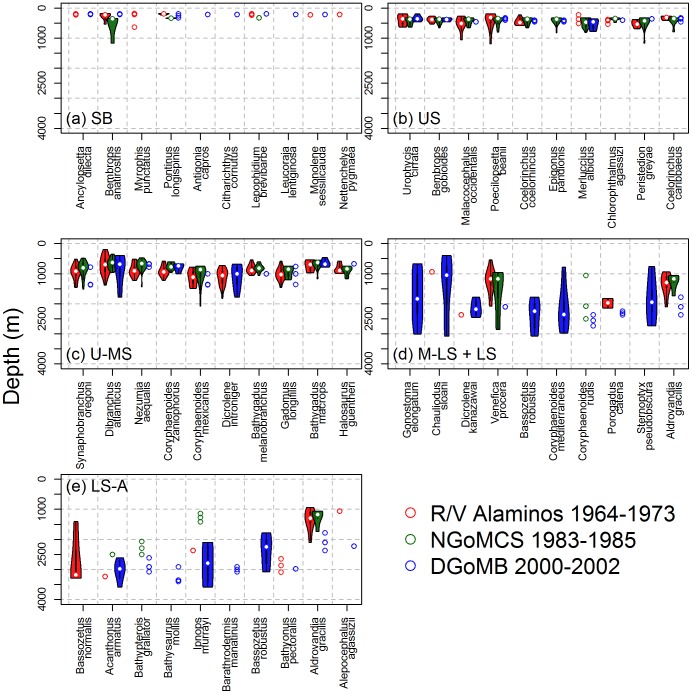
Violin plots of sampling depths for the top-10 most common species (with highest occurrence) from (a) Shelf Break, (b) Upper Slope, (c) Upper-to-Mid Slope, (d) Mid-to-Lower and Lower Slope, and (d) Lower-Slope-to-Abyssal Groups.Colors indicate the studies of different sampling times. The violin plot is a combination of box plot and kernel density plot, which started with a standard box plot (with minimum, lower quartile, median, upper quartile, and maximum depth values) and then added rotating kernel density plots to each side of the box plot. When the sampling depths were equal or less than three observations, the raw depth values were shown directly.